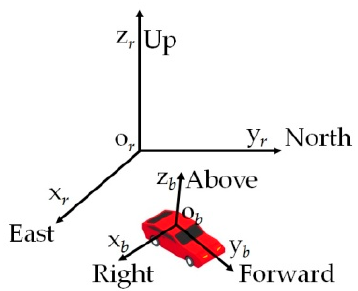
Figure 1. Reference frame o r x r y r z r and body frame o b x b y b z b